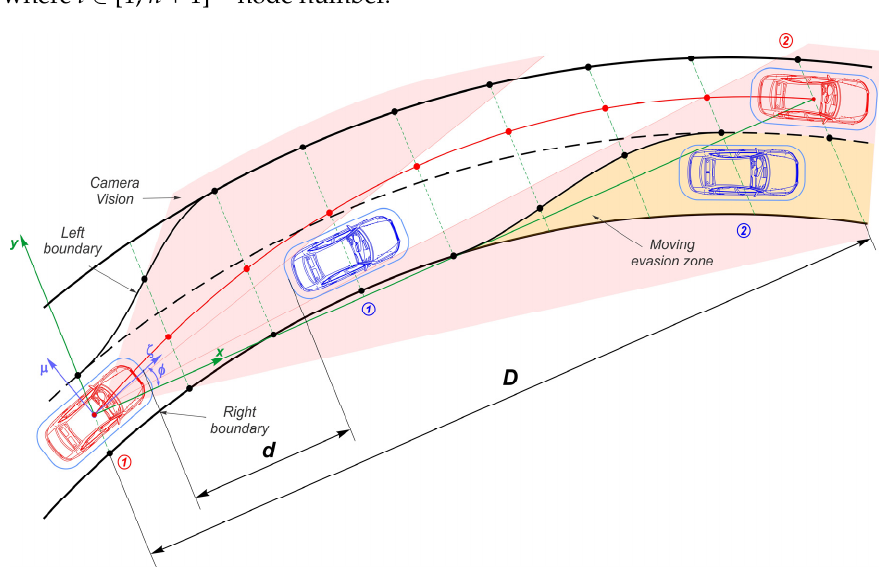
Figure 2. Scheme of the generalized task of planning the AV’s maneuver.